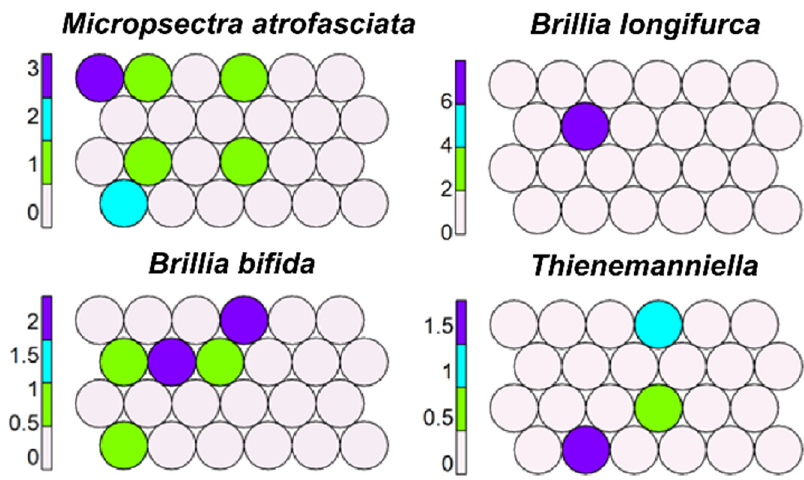
Figure 3. Unsupervised map of four morphotaxa characterizing krenal. Many morphotaxa, such as Euorthocladius , Tvetenia , Synorthocladius semivirens , and Eukiefferiella claripennis , were present in several cells characterizing rhithral (cells 1, 7–9, 14–15) (Figure 4). Other morphotaxa, such as Conchapelopia pallidula and Uresipedilum, were widespread but preferred rhithral (Figure 4). Other morphotaxa mapped in rhithral were Paracricotopus , Paratrichocladius rufiventris , Nanocladius , Orthocladius spp., Rheocricotopus, and Polypedilum.